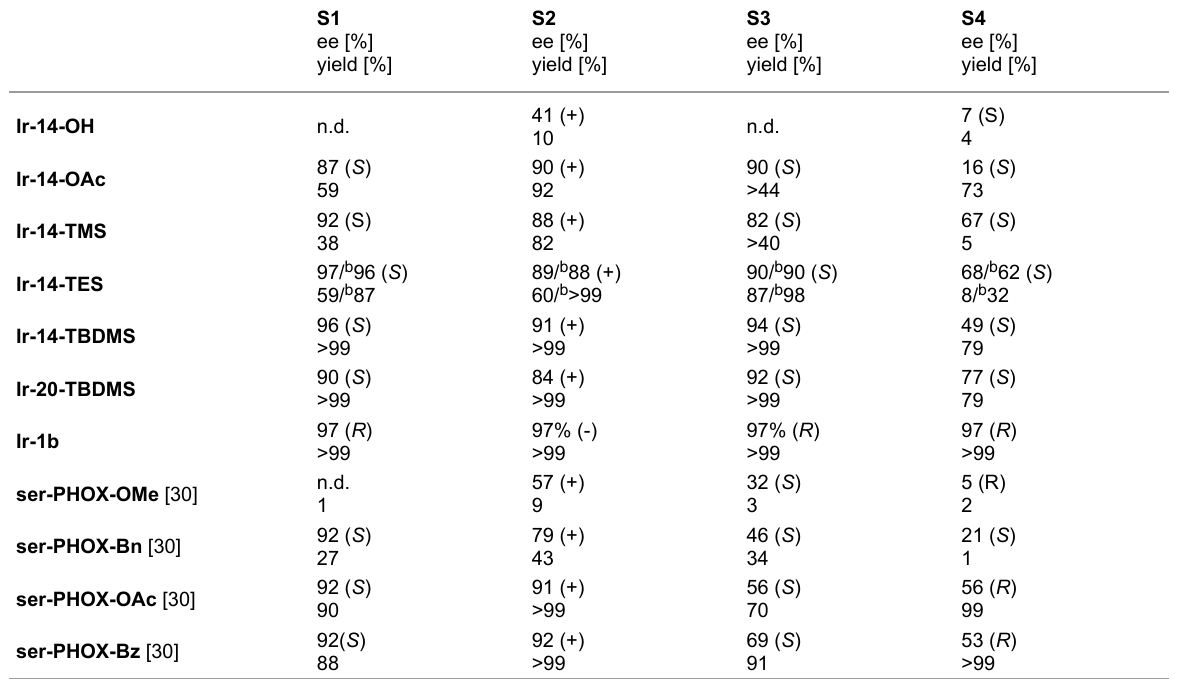
Table 2: Hydrogenation of standard substrates using serine- and threonine-derived NeoPHOX